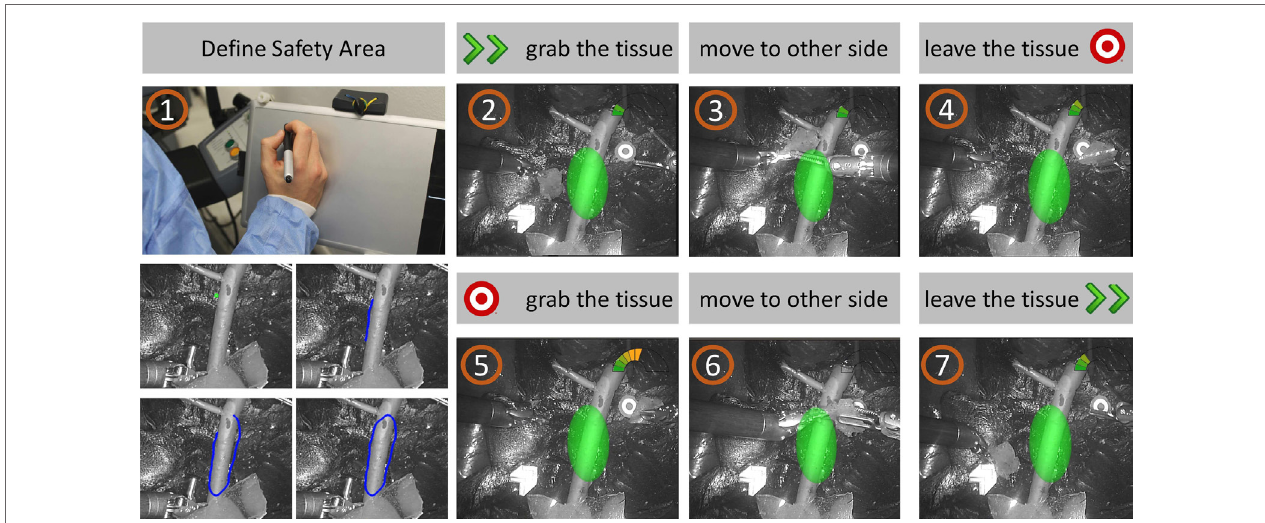
FigUre 11 | Task storyboard . The subject was asked to (1) define the SA using the stylus and the graphics tablet; (2) grab the piece of tissue from the starting point; (3) move the tissue to the other site of the operating field, paying attention to keep a certain distance from the delicate vessels; (4) leave the tissue to the target point; (5-6-7) repeat the task from the target to the starting point.